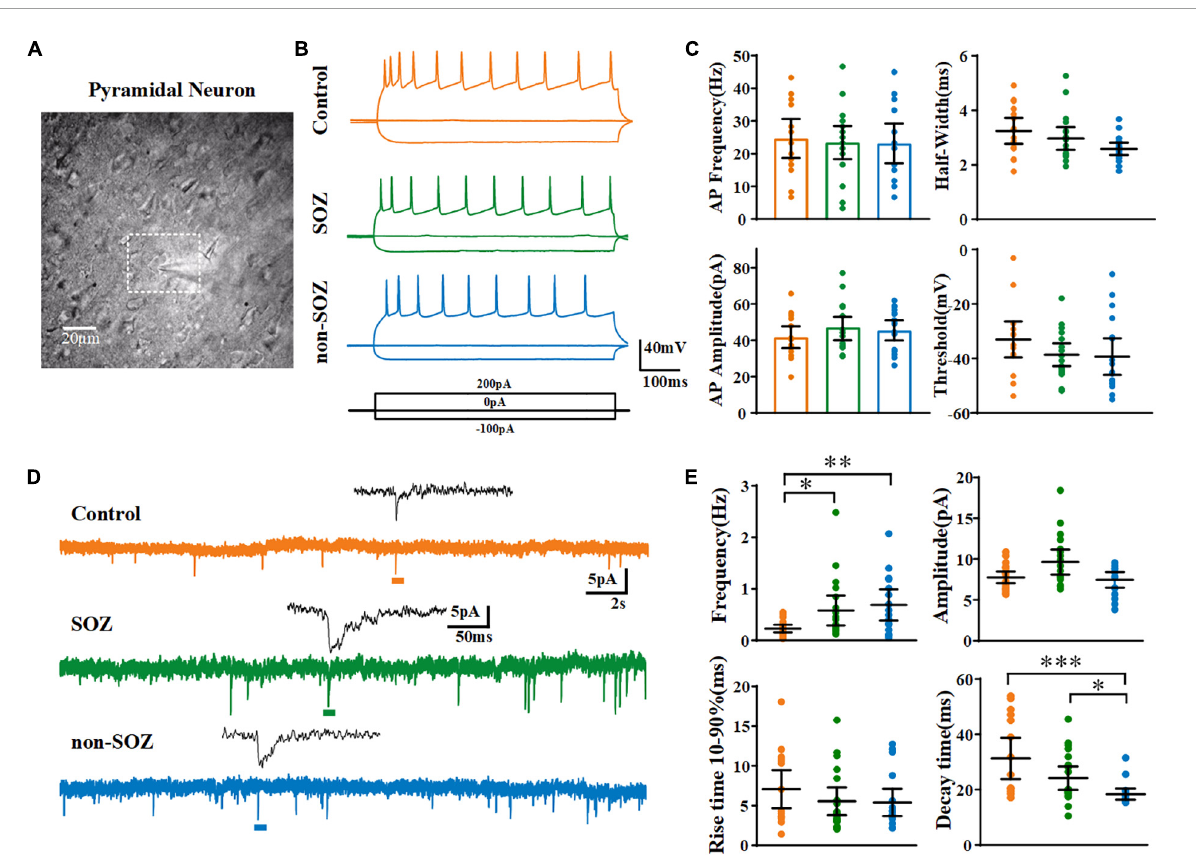
FIGURE2 Electrophysiological characteristics and spontaneous excitatory postsynaptic currents of pyramidal neurons (PN) among groups. (A) Photomicrographs of individual PN within the dysplastic cortex. (B) Representative traces and action potential firing of pyramidal neurons from the SOZ, non-SOZ, and control groups with –100, 0, 200 pA injection at the resting membrane potential. (C) Representative traces of spontaneous excitatory postsynaptic currents obtained in the three groups. (D) Comparison of the electrophysiological characteristics of pyramidal neurons across the three groups N = 19, 18, 16 for SOZ, non-SOZ, and control groups, respectively. (E) Comparison of spontaneous excitatory postsynaptic currents of pyramidal neurons across the three groups. N = 20, 18, 16 for SOZ, non-SOZ, and control groups, respectively. ∗ p < 0.05, ∗∗ p < 0.01, ∗∗∗ p < 0.01. Data was shown as mean ±